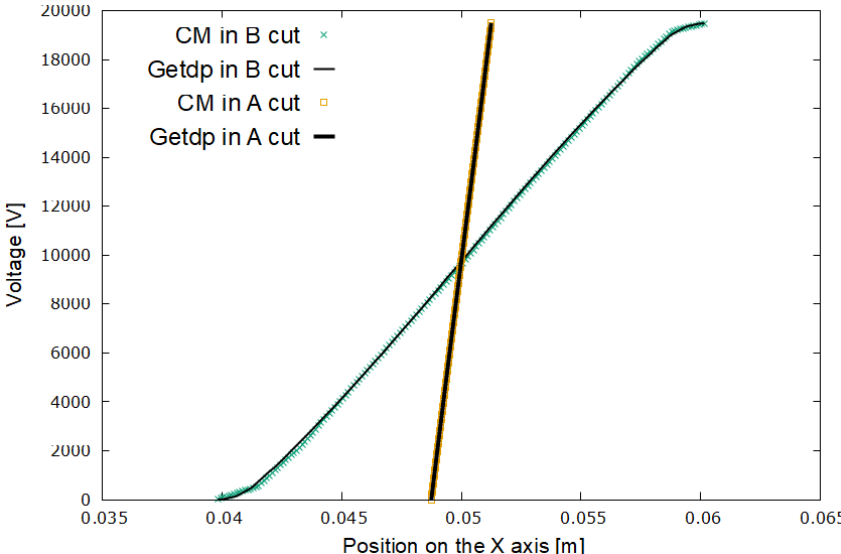
Figure 15. Voltage in cut A (steeper curves) and cut B (curves with lower slope) for experiment E2. The dielectric breakdown voltage is 19,488 V.